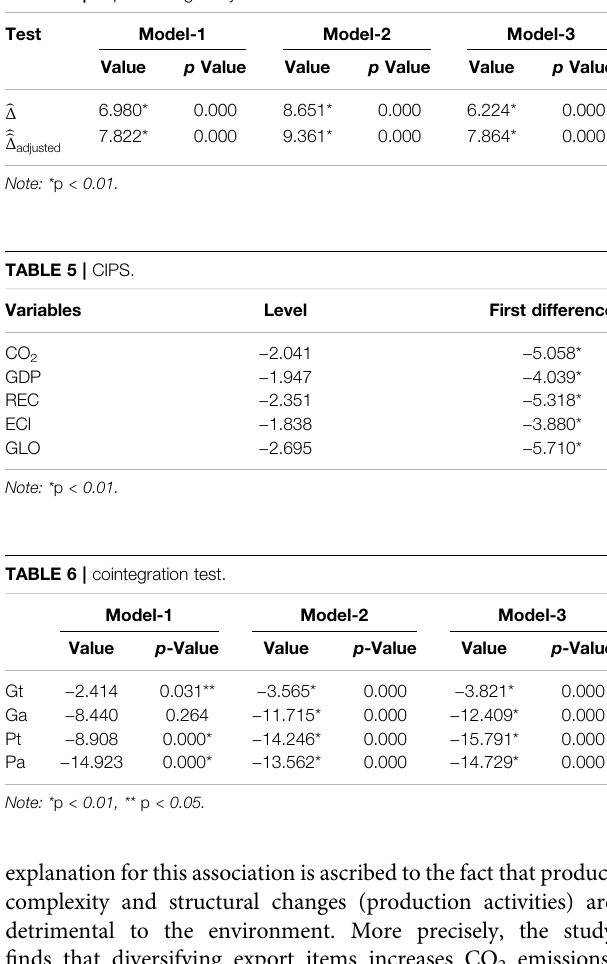
TABLE 4 | slope Homogeneity Outcomes.